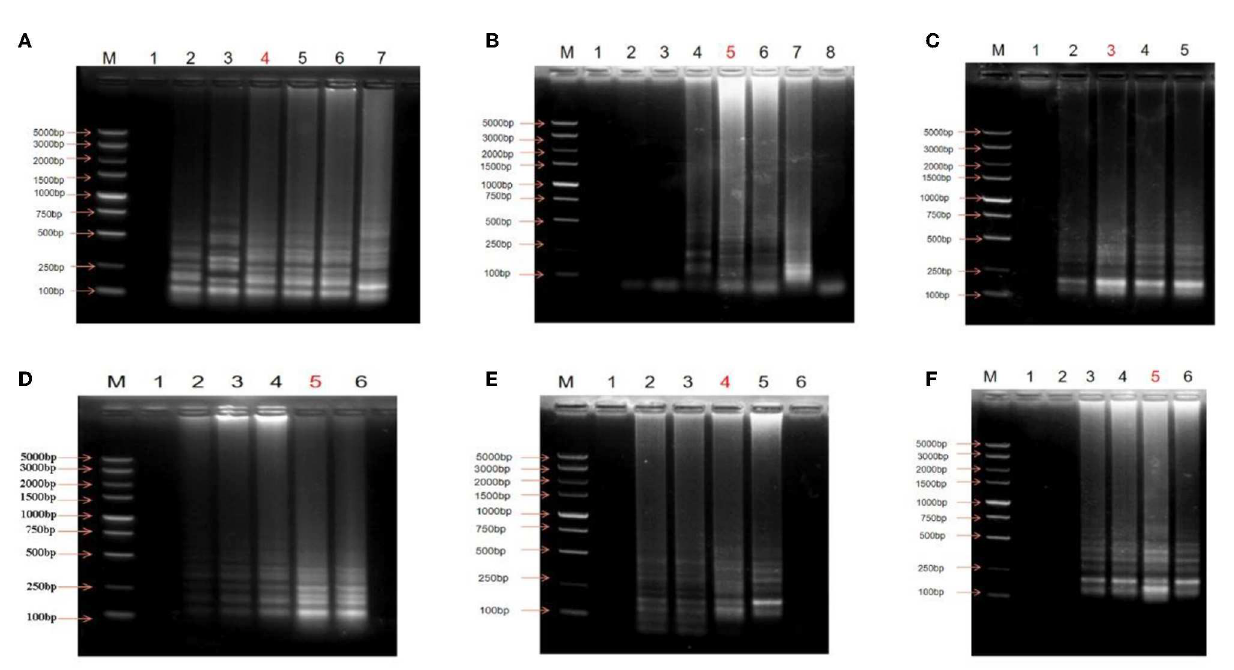
FIGURE1 Optimization of the LAMP reaction. (A) Optimization of dNTPs concentration, M: DNA Maker DL5000; lane 1: Negative control; lane 2: 4mM; lane 3: 6mM; lane 4: 8mM; lane 5: 10mM; lane 6: 12mM; lane 7: 14mM. (B) Optimization of Mg + content, M: DNA Maker DL5000; lane 1: Negative control; lane 2: 0 µ L; lane 3: 0.5 µ L; lane4: 1.0 µ L; lane 5: 1.5 µ L; lane 6: 2.0 µ L; lane 7: 2.5 µ L; lane 8: 3.0 µ L. (C) Optimization of enzyme content, M: DNA Marker DL5000; lane 1: Negative control; lane 2: 0.5 µ L; lane 3: 1.0 µ L; lane 4: 1.5 µ L; lane 5: 2.0 µ L. (D) Optimization of primer concentration ratio